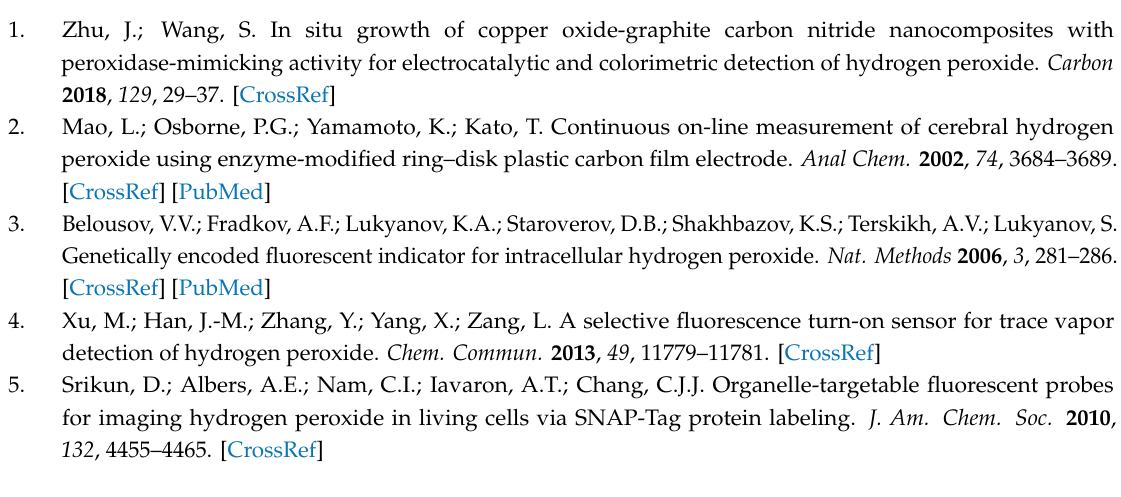
Figure S1: UV–vis absorption spectra of MoSe 2 QDs with di ff erent concentrations of H 2 O 2 , Figure S2: UV–vis absorption spectra of 2D CTAB-MoSe 2 NSs with di ff erent amounts of H 2 O 2 , Table S1: Michaelis–Menten parameters of the 2D CTAB-MoSe 2 NSs and 0D MoSe 2